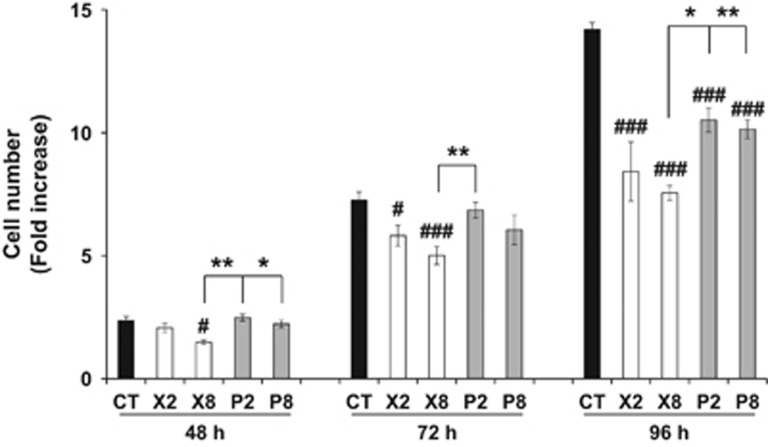
CAL33 proliferative ability following multiple X or P irradiations. Counts of CAL33 cells following multiple low (2 Gy) or high (8 Gy) dose(s) of P or X irradiation and cell expansion after the third irradiation (CR-MI). The values correspond to fold increase, as compared to the viable cell number at 24 h after cell seeding. Significantly decreased viable cell counts, as compared to CT: #, P<0.05; ###, P<0.001. Significantly increased viable cell counts for comparisons between X and P groups: *, P<0.05; **, P<0.01. CT, control (non-irradiated cells).